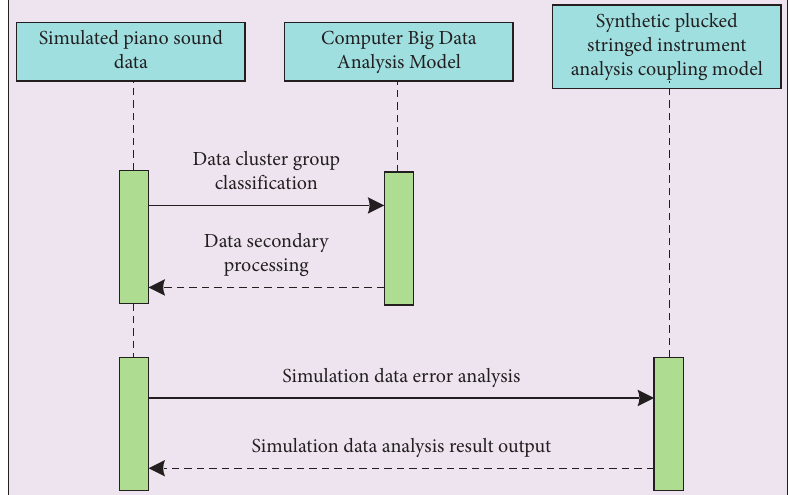
Figure 2: Discrete dynamic modeling technology to simulate guqin sound